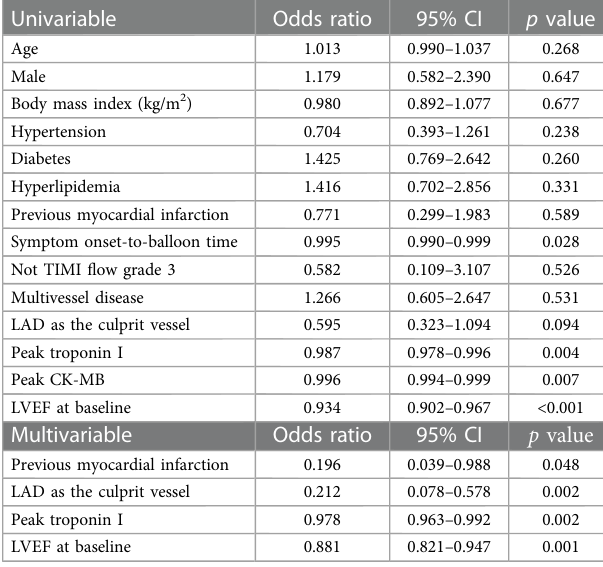
TABLE 5 Clinical characteristics of patients according to the optimal cut-off value for the predictive